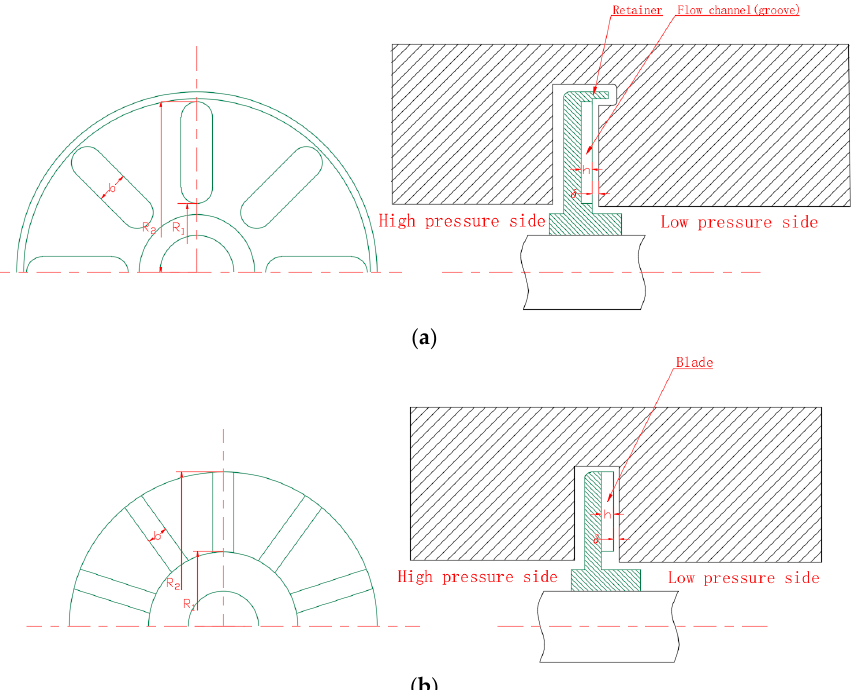
Figure 3. Structural diagram of liquid-sealing impellers: ( a ) open impeller with flow channel (groove) and retainer and ( b ) open impeller with blades.